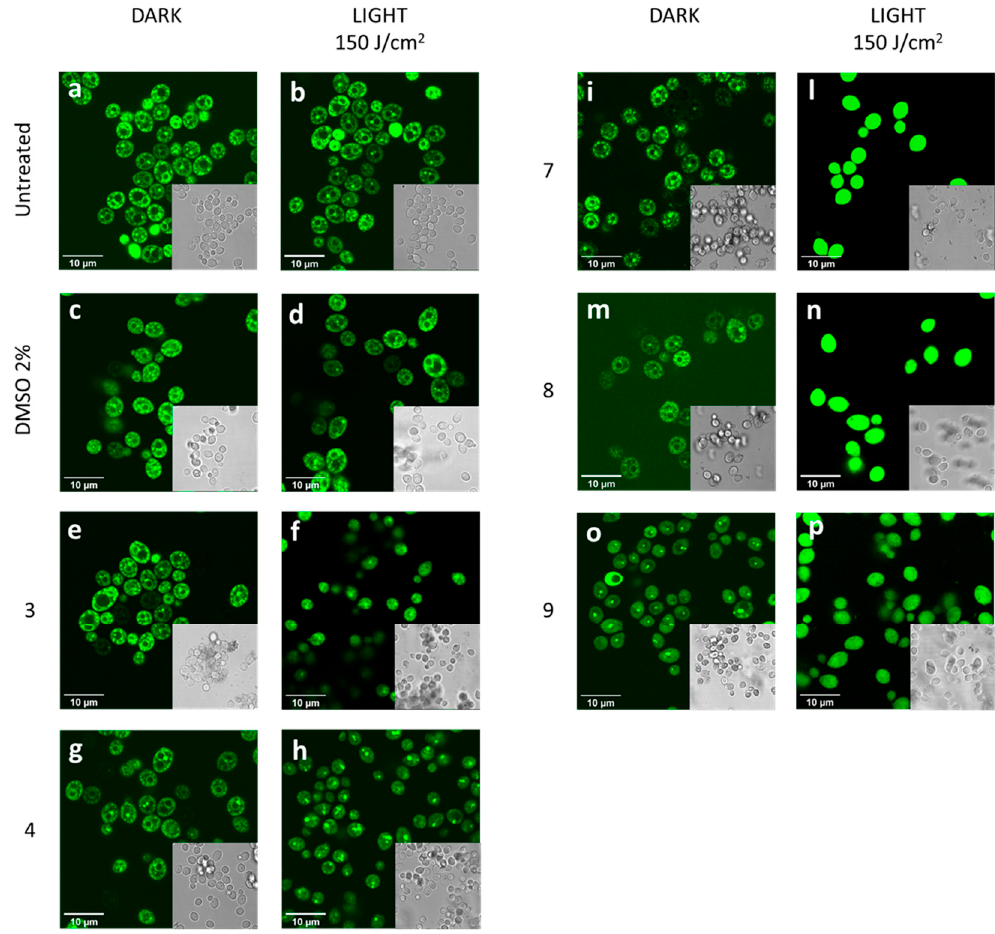
Figure 6. Confocal analyses of Candida albicans cells upon photodynamic treatment with Porphyrins 3 , 4 , 7 – 9 (10 µM) activated by blue light (150 J/cm 2 ). Samples treated with 2% DMSO are also included. Scale bar = 10 µm. Dark incubated samples are presented in Panels ( a ), ( c ), ( e ), ( g ), ( i ), ( m ), and ( o ), while light-treated samples are presented in panels ( b ), ( d ), ( f ), ( h ), ( l ), ( n ), and ( p ).